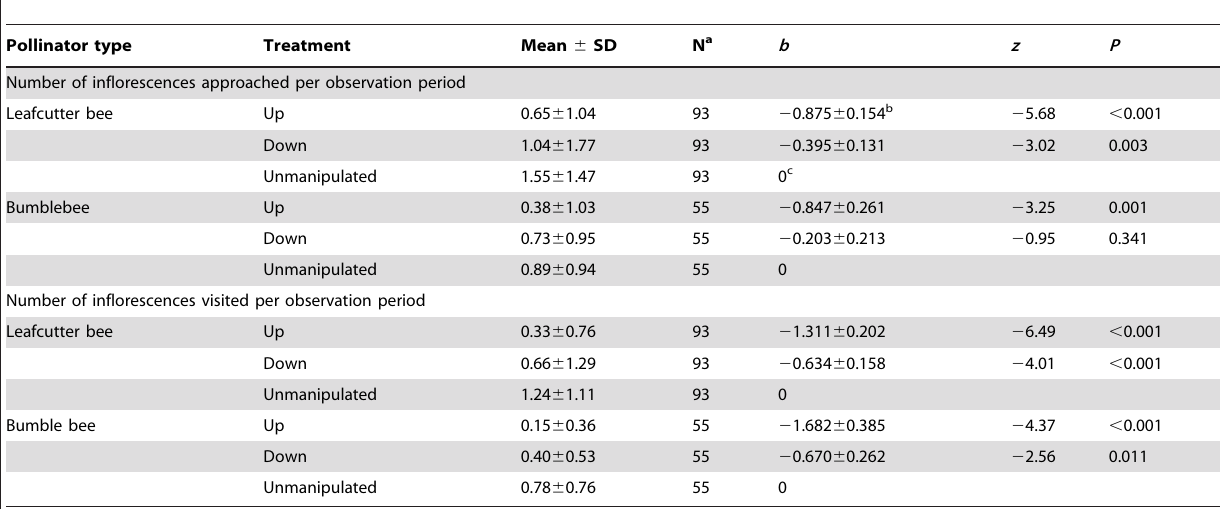
Table 1. Effects of changes in floral orientation on the number of inflorescences approached and visited per observation period (Mean 6 SD) by leafcutter bees and bumble bees based on generalized linear model (GLM).